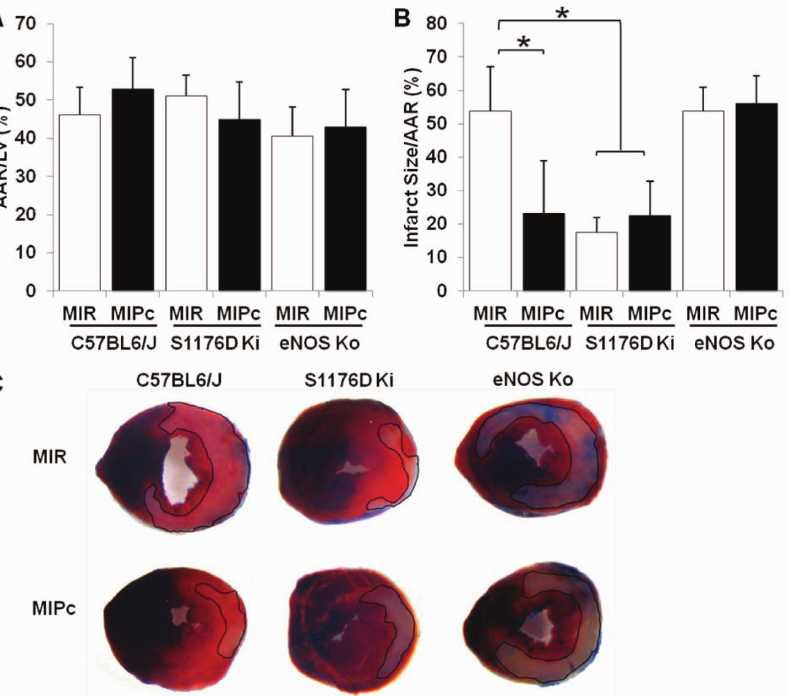
Figure 1. eNOS S1176 phosphorylation protects against I/R injury in vivo. Wild-type, S1176D and eNOS knockout mice were subjected to 45 minutes of myocardial ischemia (LAD ligation) followed by traditional reperfusion (MIR) or postconditioned reperfusion (MIPc: 6 cycles of 10sec reperfusion, 10 sec ischemia). A. Percentage of left ventricle area at risk (AAR), (P=NS). B. Quantitative analysis of infarct size over AAR, *P , 0.05 compared to wild-type control. C. Representative heart sections perfused with 1% Evans blue and stained with 2% TTC; infarct areas are outlined in black. MIR: Myocardial ischemia with reperfusion, MIPc: Myocardial ischemia with postconditioning, AAR: Area at Risk, LV: Left Ventricle. n=6–9 mice per group. Data are expressed as the mean 6 SD.